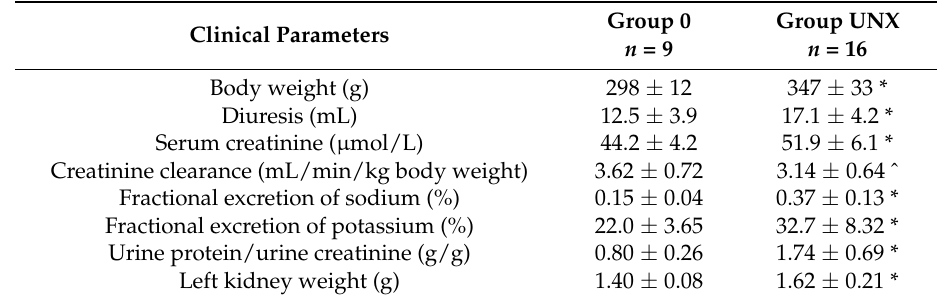
Table 2. Renal function parameters in intact 9-week-old male Sprague-Dawley rats (Group 0) and in 11-week-old such rats at 2 weeks after unilateral nephrectomy (Group